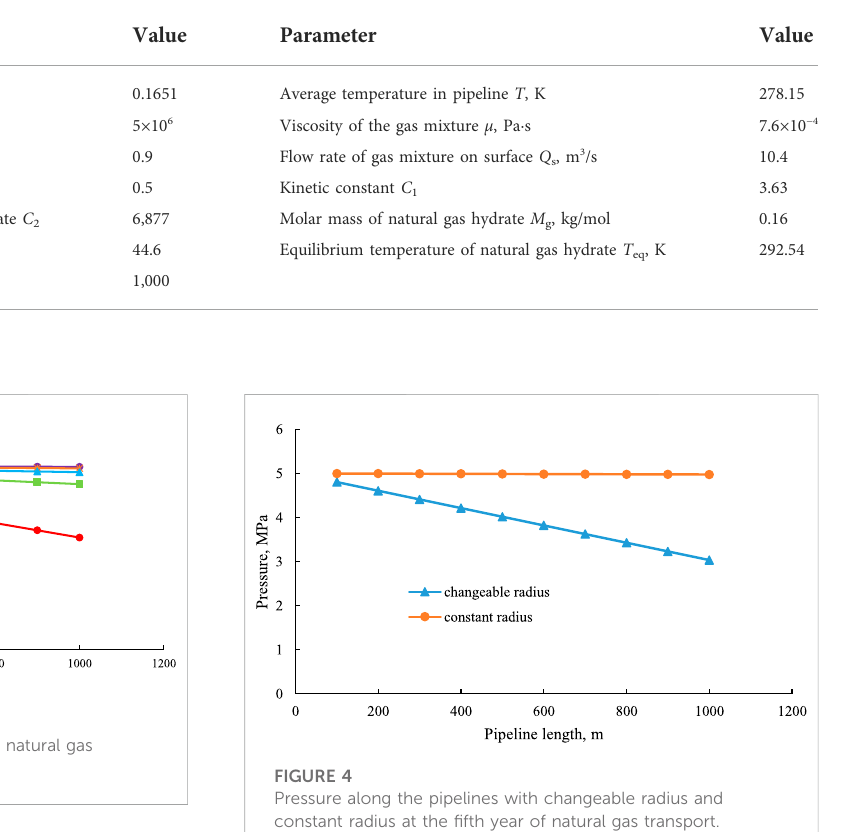
TABLE 2 Data of the parameters for model application.